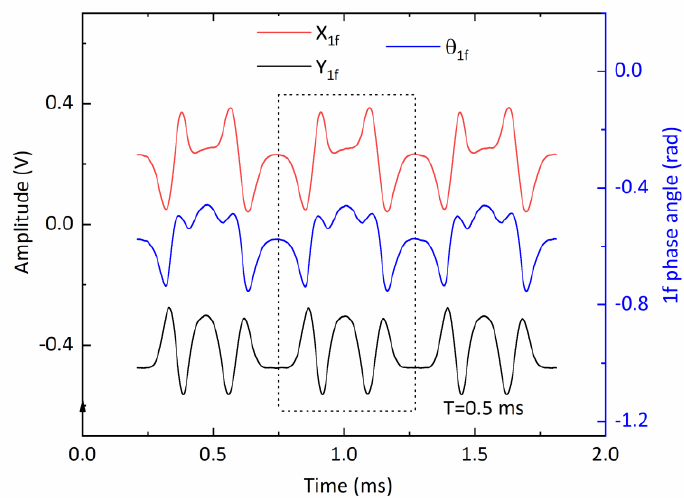
Figure 7. The extractions of the first harmonic signals via anlage quadrature lock-in amplifiers and the calculated first harmonic phase angle. The dotted box indicates a single scan period.